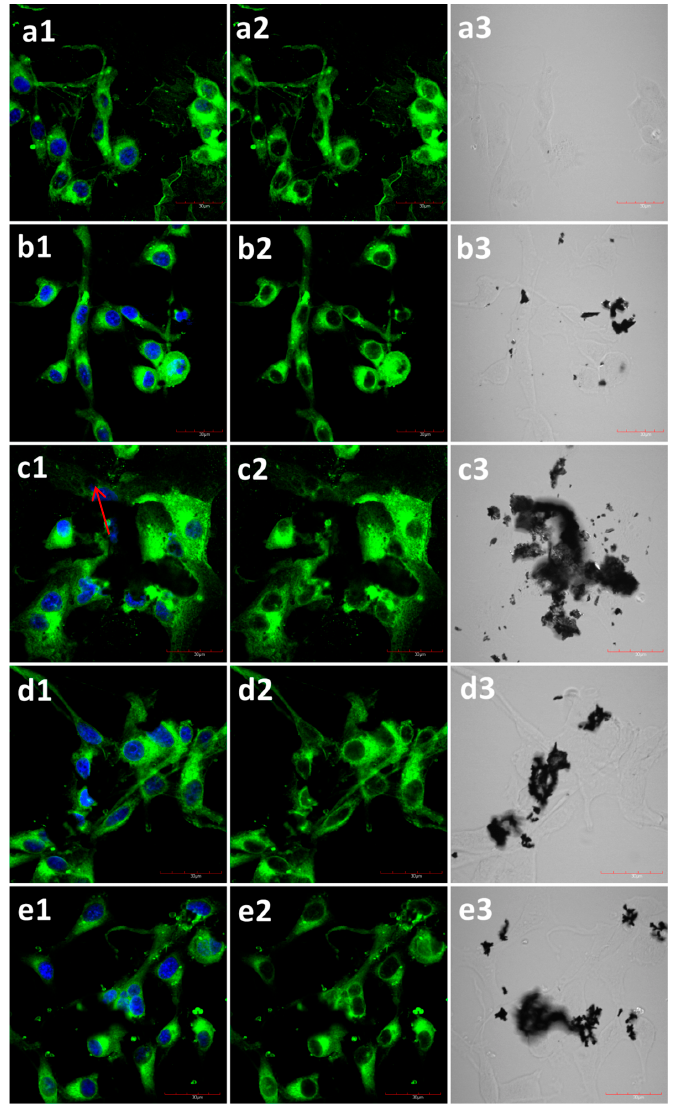
Figure 4. Morphology of untreated U87 cells and those treated with GN and rGO flakes at a concentration of 50 µ g/mL after 24 h evaluated by confocal microscopy. Images show the untreated control ( a ) group and groups treated with: GN/ExF ( b ), rGO/Term ( c ), rGO/ATS ( d ), and rGO/TUD ( e ). The pictures marked with the number ( 1 ) show the combination of 4-Di-10-ASP (green) and DAPI (blue); (2) show the 4-Di-10-ASP (green); and ( 3 ) show the DIC contrast. The red arrow marks damage to the cell membrane. Scale bar: 30 µ m Abbreviations : rGO, reduced graphene oxide; GN, graphene; DAPI, 4 (cid:48) ,6-diamidino-2-phenylindole; 4-Di-10-ASP, 4-(4-(didecylamino)styryl)- N -methylpyridinium